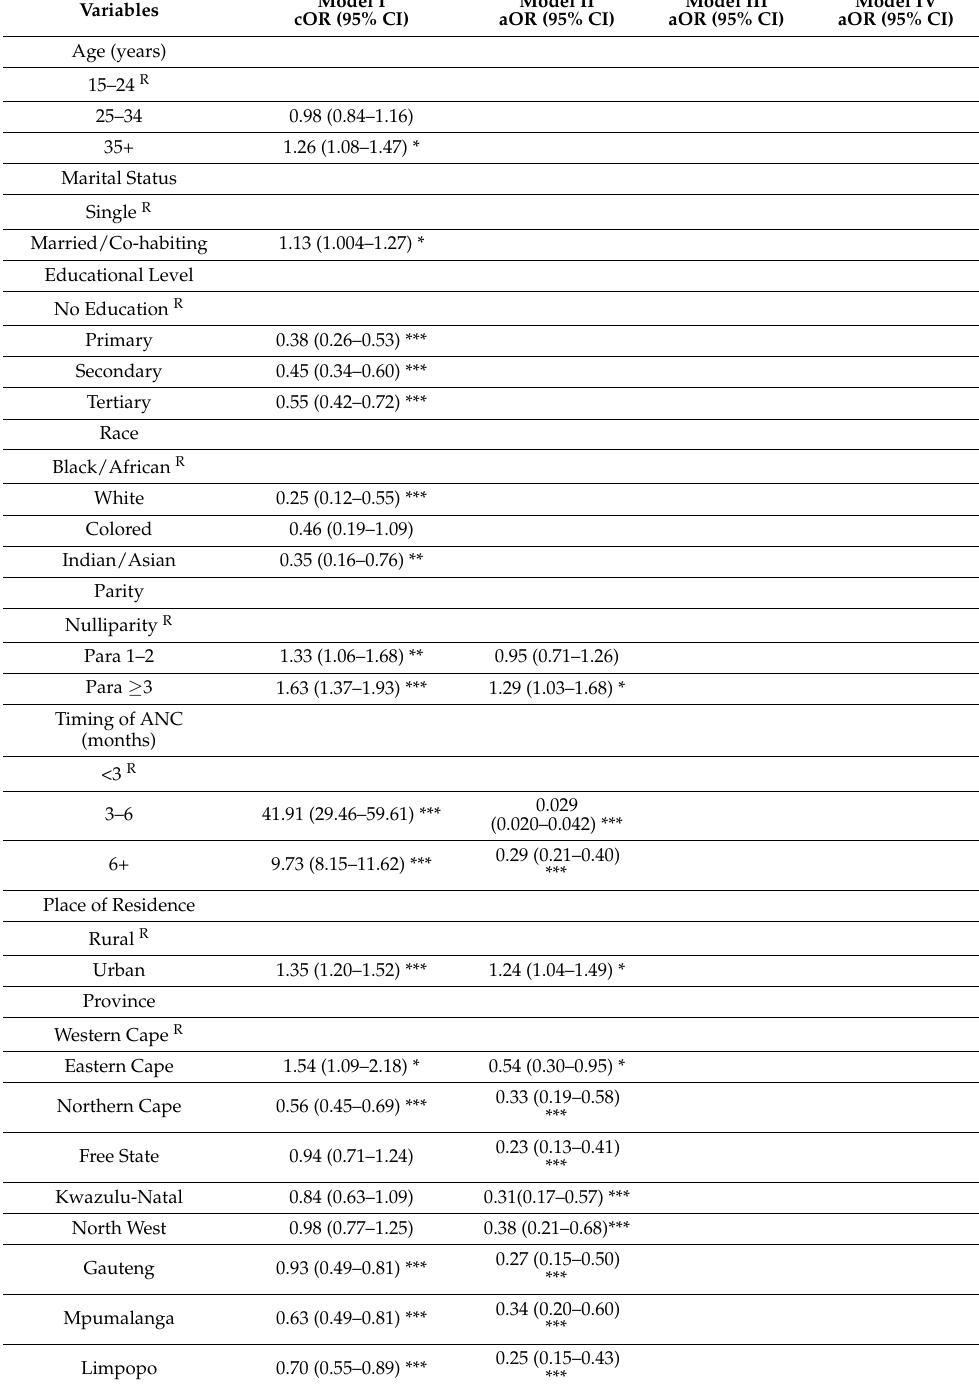
Table 3. Multilevel Multivariable Logistic Regression Results for Factors Associated with the Utiliza- tion of Antenatal Care Services among Women of Reproductive Age in South Africa ( n =